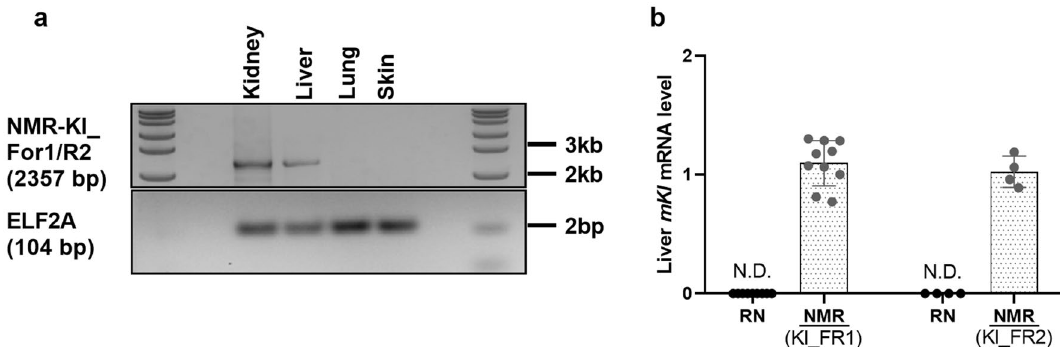
Figure 3. Expression of klotho in the liver of the Naked Mole Rat. The potential extrarenal expression of Kl in NMR was examined in the liver, lung, and skin by PCR on a long fragment of the coding region of NMR Kl (2357 bp). Each lane consists of pooled tissues from five rats ( a ). The relative mRNA expression of Kl in the liver was further measured by qPCR using two different primers (Kl_FR1 and Kl_FR2) for NMR and compared to that of RN. The Kl expression was quantified and normalized to reference genes. In NMR, a high expression of Kl mRNA was detected in the liver ( p < 0.0001), while no Kl was found in the liver of RN ( b ). N.D.: not detectable. n = 5–12 in each group. NMR: Naked Mole Rat; RN: Rattus Norvegicus; Kl : klotho Identification of mKl in the liver of NMR by Sanger sequencing. The long fragment of the ampli- fied band for mKl (2357 bp) in the NMR kidney and liver was amplified (Supplementary Fig. 1) and sequenced to verify the mKl transcript in the liver. As Sanger sequencing can only sequence less than 1000 bp, six other short primers were designed by GenScript with a dispense of 400 bp between sequencing primers (Table 3). The sequenced fragments of the liver were aligned to the sequenced fragments of mKl from the kidney (Supplemen- tary Fig. 2), which previously has been confirmed to represent mKl by aligning to the published sequence from NCBI. The sequenced klotho in the liver was identical to that found in the kidney. Thus, these results clearly indicate that the liver of NMR expresses mKl .